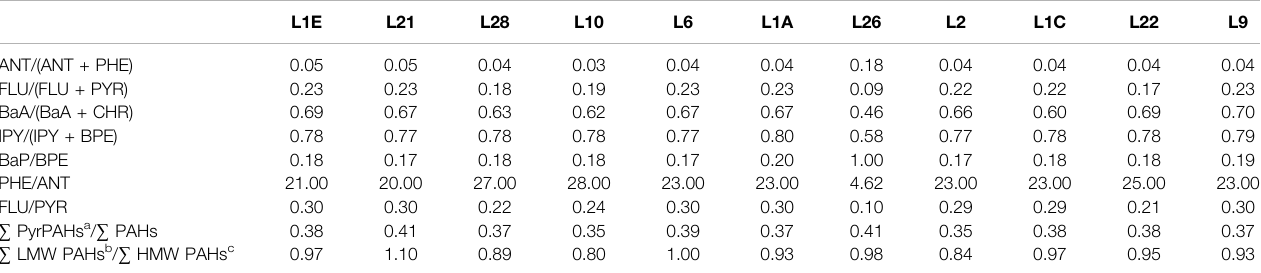
TABLE 4 | PAHs isomer ratios in studied soils and cryoconites.